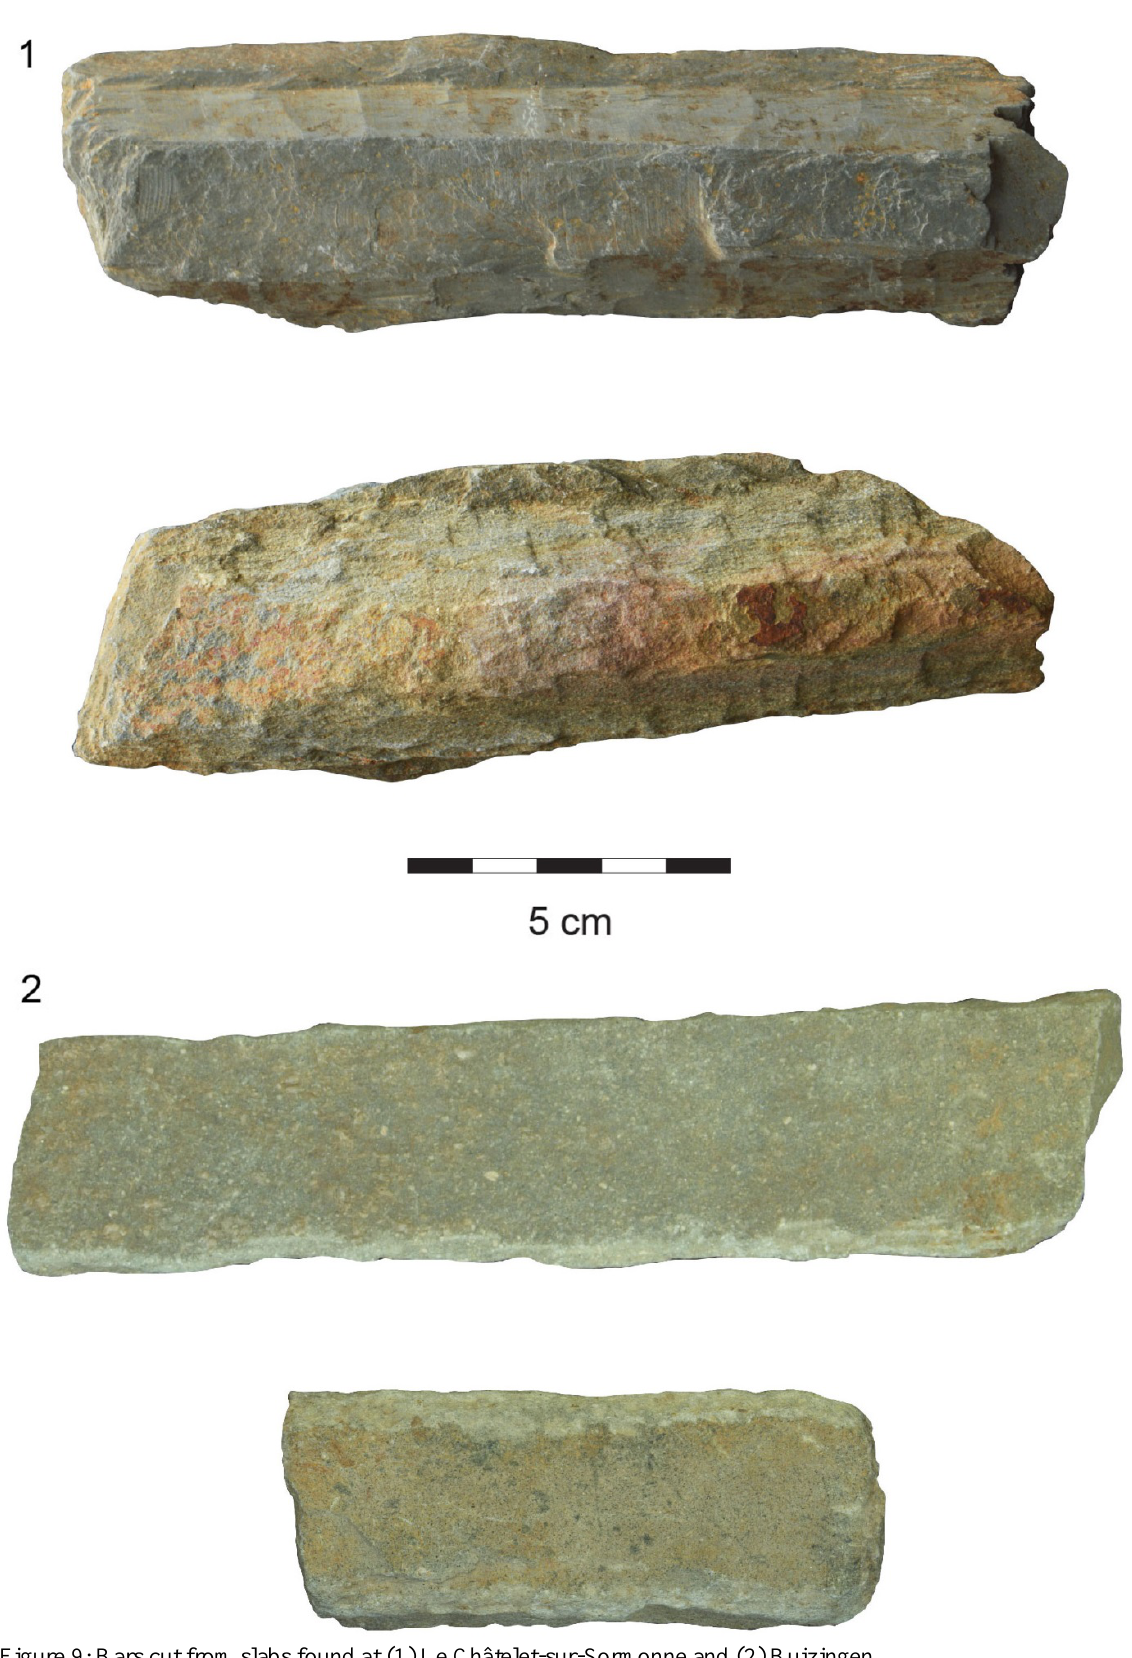
Figure 9: Bars cut from slabs found at (1) Le Châtelet-sur-Sormonne and (2)